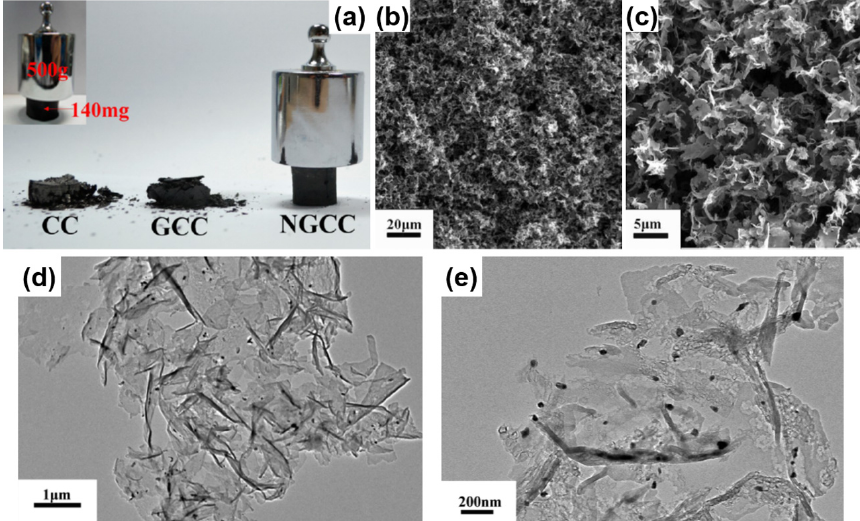
Figure 9. ( a ) Digital photographs of carbon cryogel (CC), graphene/carbon cryogel (GCC), and Ni-doped graphene/carbon cryogel (NGCC) with the same weight (90 mg) after loading with 200 g weight; (inset) 140 mg Ni-doped graphene/carbon cryogel monolith enduring a weight of 500 g. ( b , c ) SEM images and ( d , e ) TEM images of Ni-doped graphene/carbon cryogel. Reproduced with permission of Ref. [179] (Copyright American Chemical Society